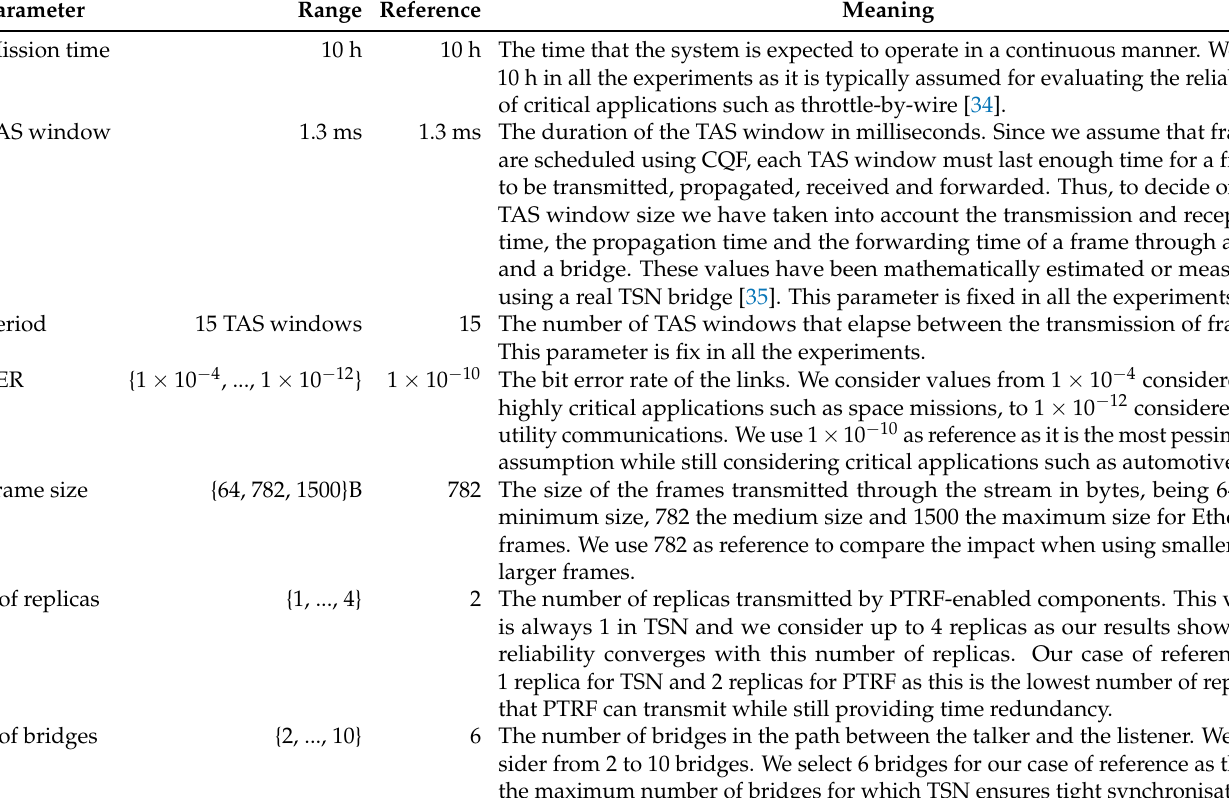
Table 3. Parameters tuned in the the sensitivity analysis.